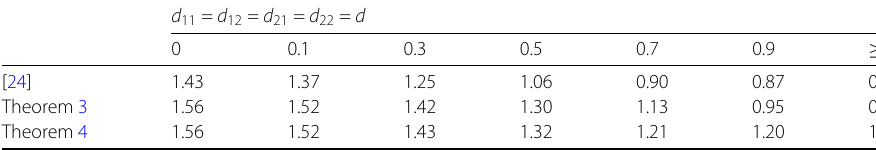
Figure 1 State responses of system (24) ( τ ij = 1.5)